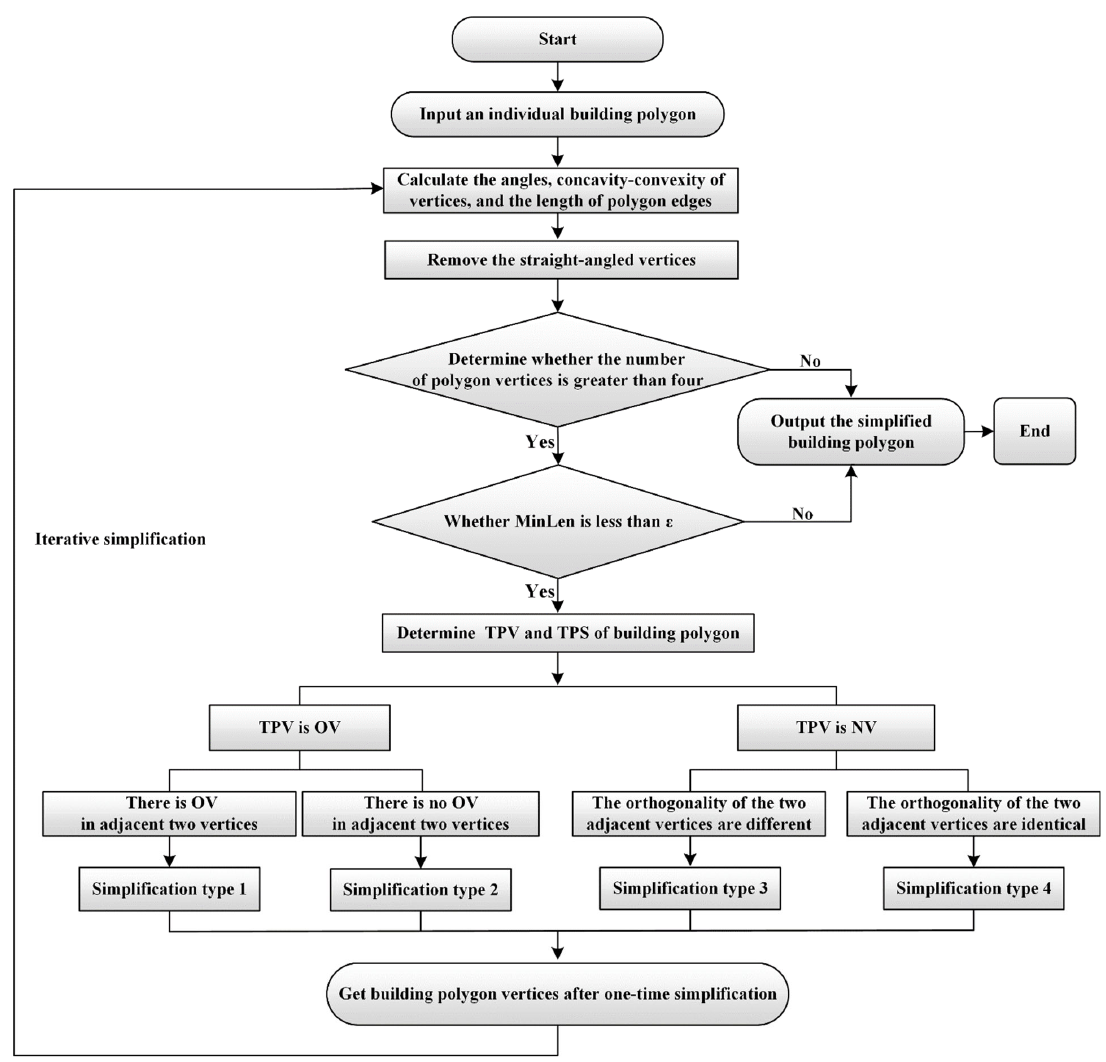
Figure 4. The framework of our approach.